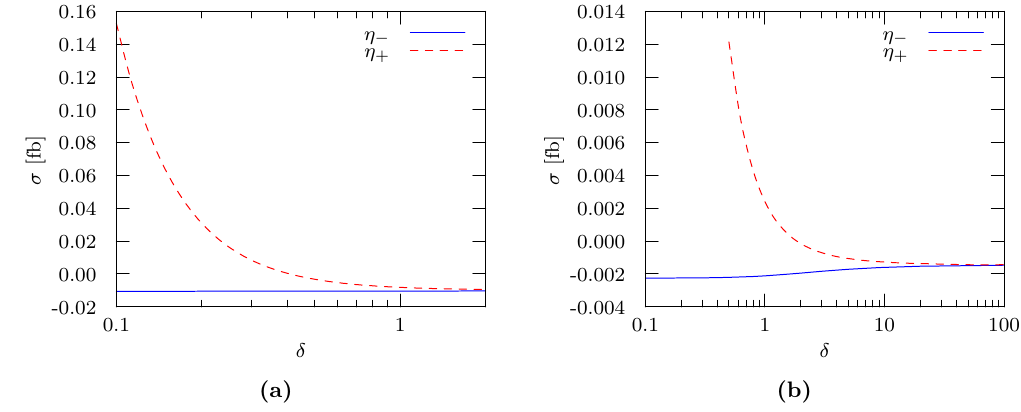
Figure 7. Gauge dependence of a diagram removed gq ! ~ u L ~ u y (b) matrix elements. See eqs. (5.27) and (5.28) for the de(cid:12)nition of (cid:17) (cid:0) and (cid:17) +